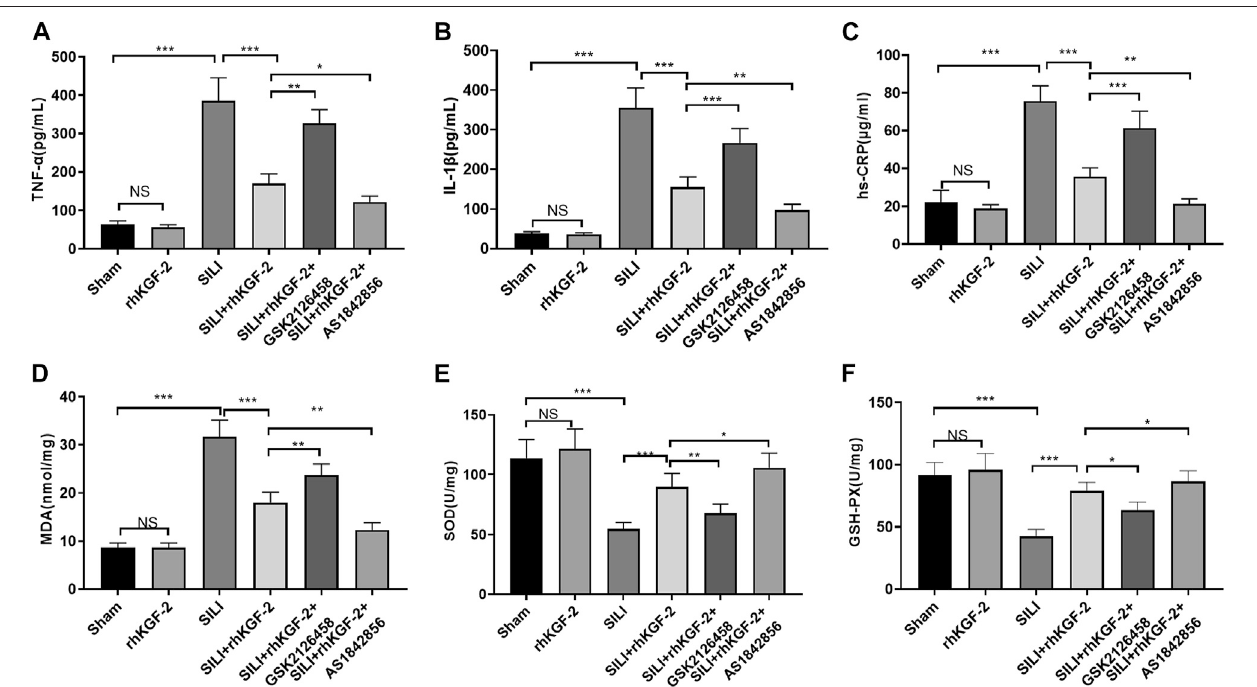
FIGURE 6 | rhKGF-2 eased the in fl ammation and oxidative stress in the SILI rat model. The SILI rat model was established by inhalation of smoke. Then, rhKGF-2 (10 ng/kg body weight), GSK2126458 (300 μ g/kg body weight) and AS1842856 (10 μ g/kg body weight) were used for were used for treating the SILI rats, the same volume of saline was administered on the rat in the sham group. A – F: The release of pro-in fl ammatory cytokines TNF- α (A) , IL-1 β (B) , hs-CRP (C) , and the levels of oxidative stress markers MDA (D) , SOD (E) , and GSH-PX. (F) in the lung of rats were determined by ELISA. The Y -axis shows the content of the detected mediators. The X -axis shows the grouping name. Data are expressed as mean ± SD. All experiments were repeated for three times. Data difference was analyzed via ANOVA, and Student ’ s t test. NS P ＞ 0.05, * p ＜ 0.05, ** p ＜ 0.01, *** p ＜ 0.001. Five rats were involved in each group (N (cid:2)